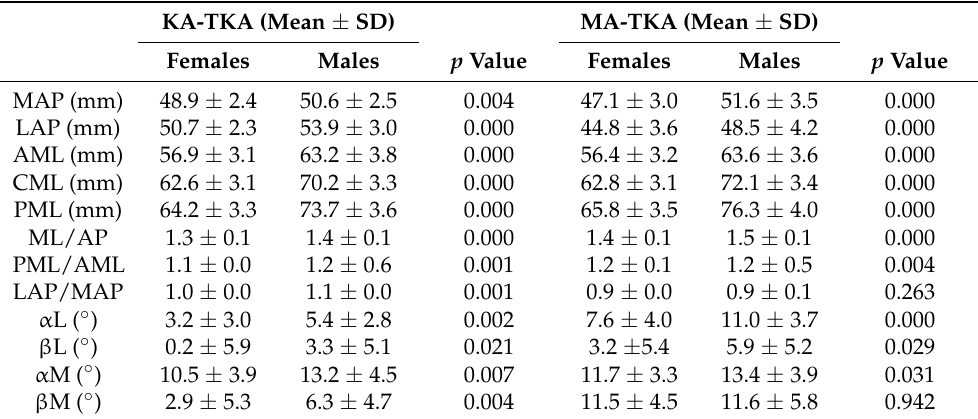
Table 5. Comparison of distal femoral dimensions between males and females who underwent KA-TKA and